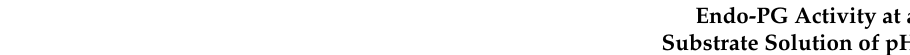
Table 2. Endo-Polygalacturonase activity at different processing stages of fungal-inoculated gherkins at pH 5.5 and a temperature of 30 ◦ C. The fungi Galactomyces geotrichum , Mucor hiemalis, and Mucor fragilis were used for